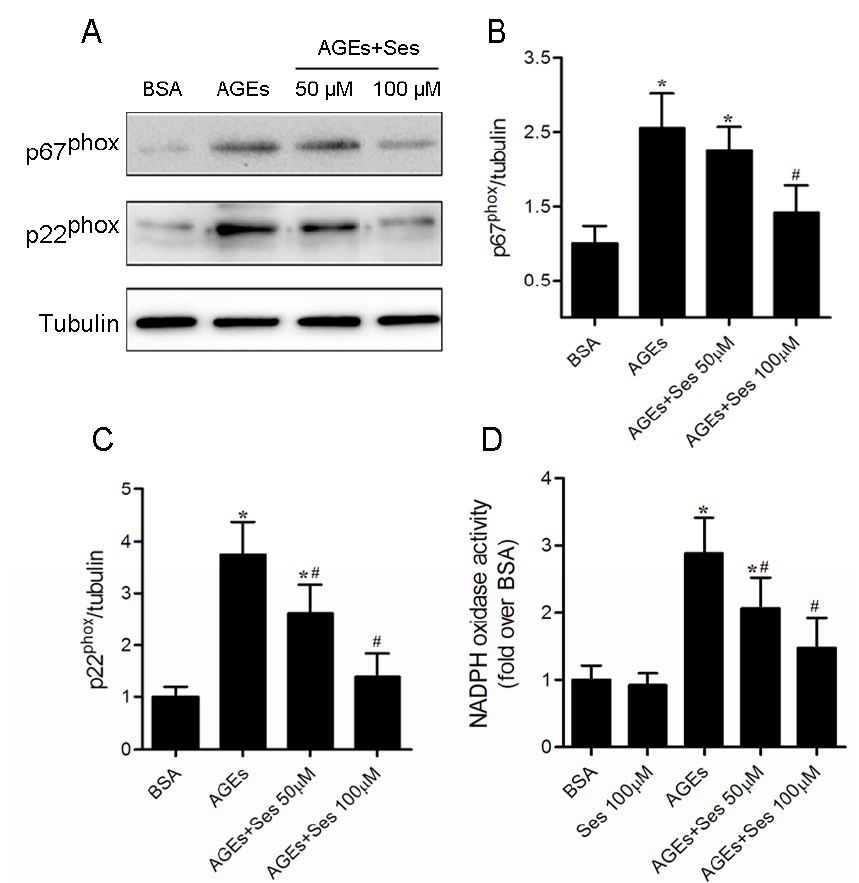
Figure 8. Effects of sesamin on expression of p67 phox and p22 phox as well as activity